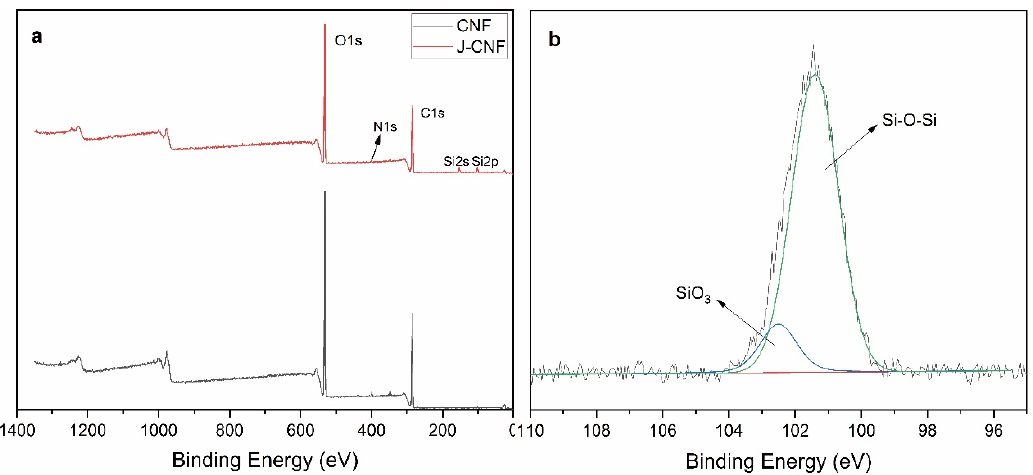
Figure 4. X-ray photoelectron spectroscopy (XPS) spectra of CNF and J-CNF: ( a ) wide scan spectra; and ( b ) Si2p spectrum of J-CNF. Table 1. Relative distribution of carbon atoms of cellulose nanofibril (CNF) and cross-linking (J)-CNF. Sample.